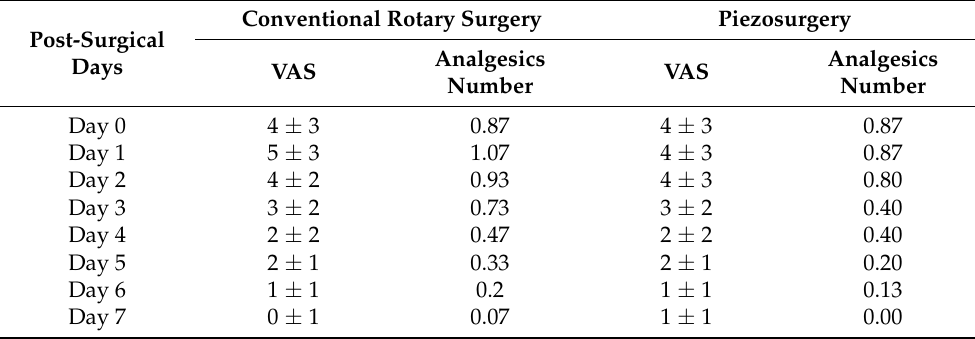
Table 1. Quantification of pain (VAS scale and number of analgesics) according to the operative technique throughout the post-surgical